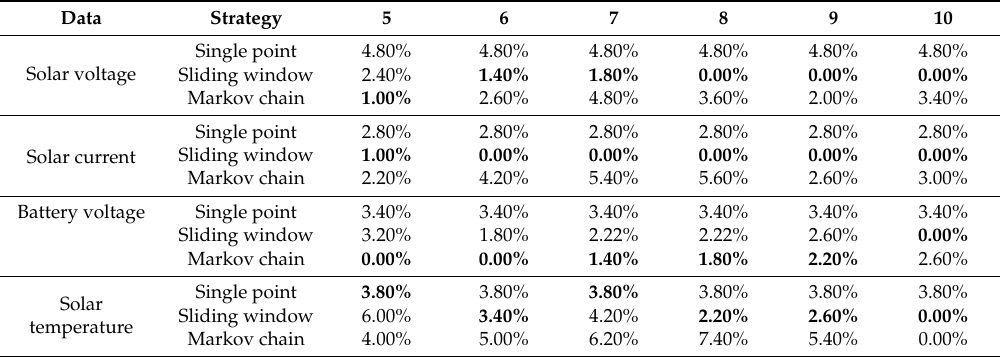
Table 3. The quantitative detection results for different series with the GPR model.